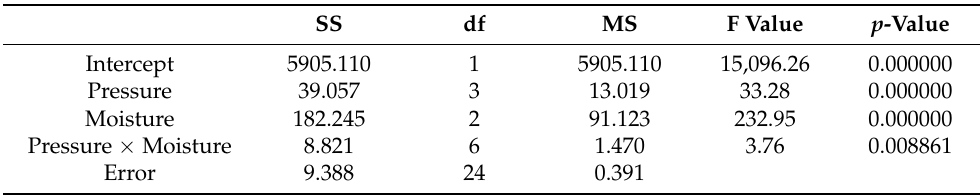
Table 1. Two-way analysis of variance (ANOVA)—miscanthus.